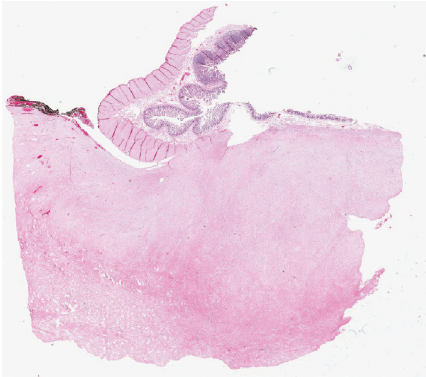
Figure 4: Low power view of the lesion in relation to the mucosa and muscular layer of the small bowel. The pink area at the bottom half of the image is all tumor.